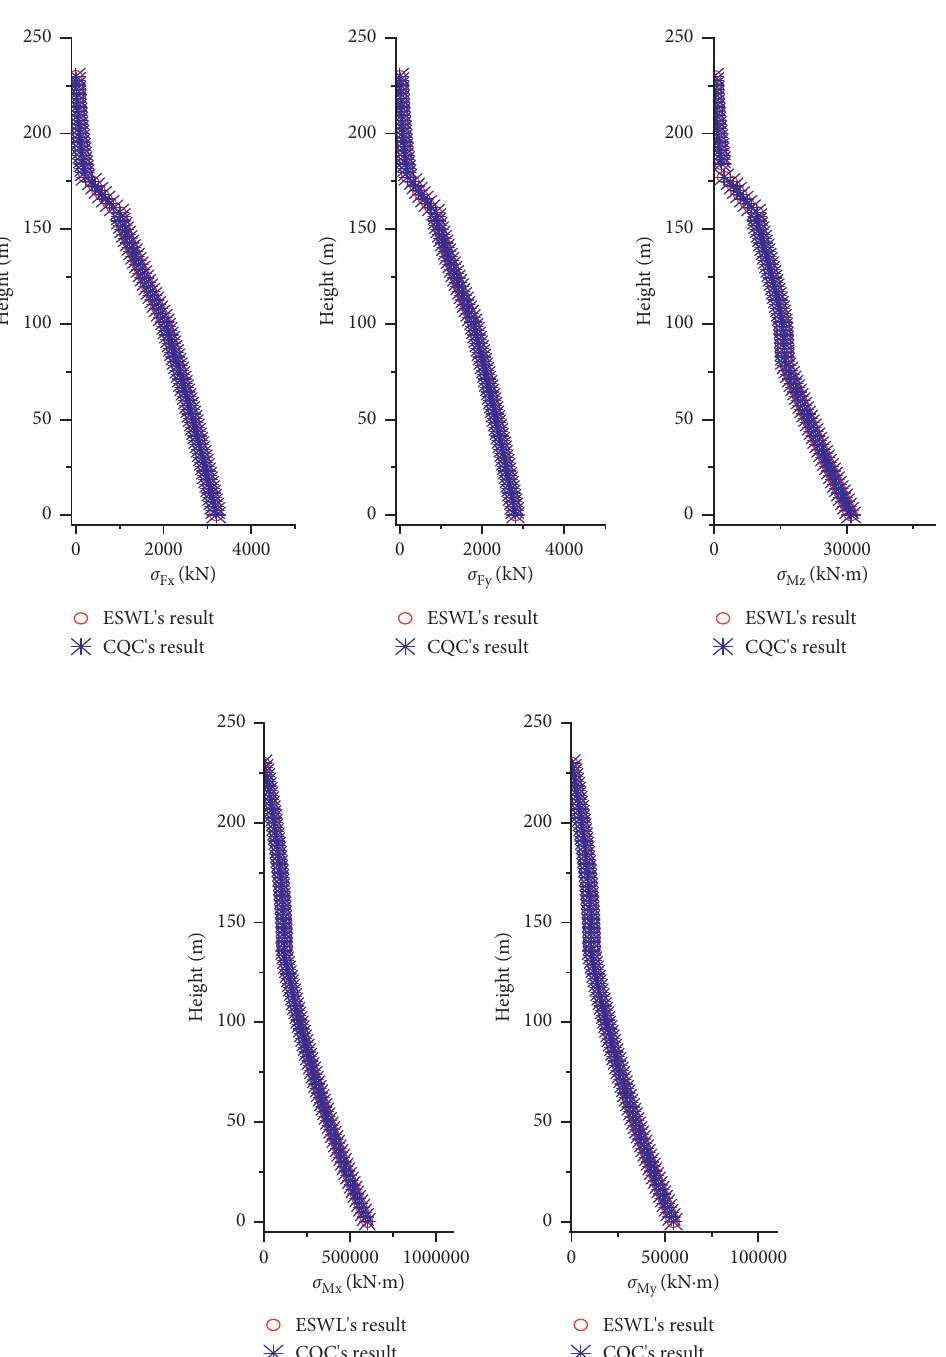
Figure 12: RMS internal force of structure (90 ° wind direction, 100 years return